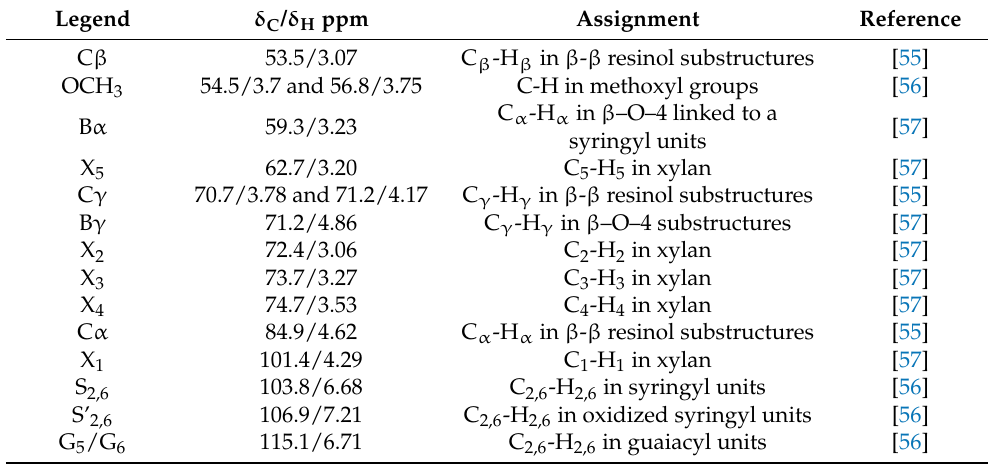
Figure 5. Nuclear Magnetic Resonance (NMR) spectrum of the lignin recovered from residual eucalyptus sawdust (LIRES). (Blue color represent the signs registered by the equipment). Table 3. Correlation signals of 2D HSQC NMR